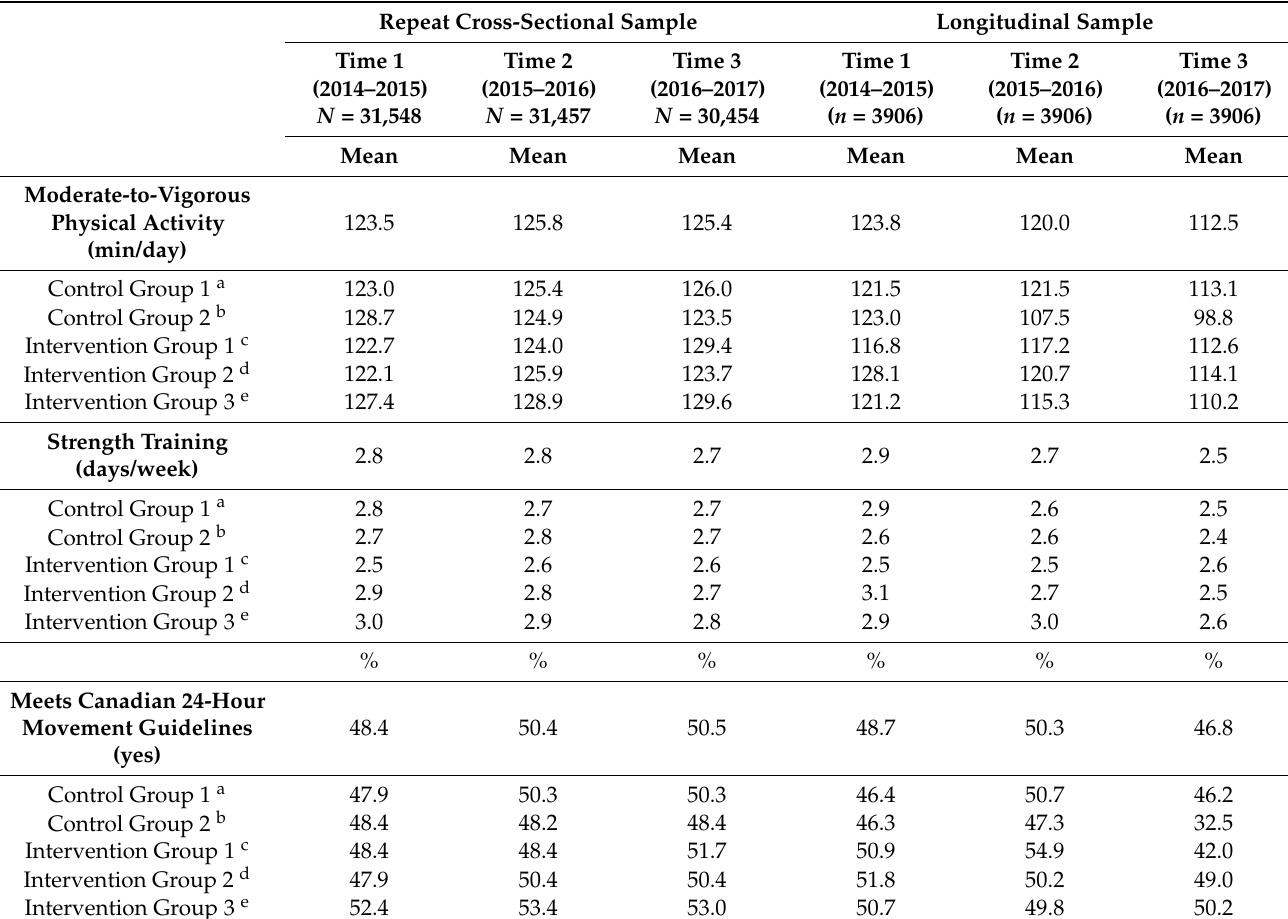
Table 1. Moderate-to-vigorous physical activity, strength training, and meeting the Canadian 24-Hour Movement Guidelines over time by group in the repeat cross-sectional and longitudinal sample of students in the COMPASS study (from 2014–2015 to